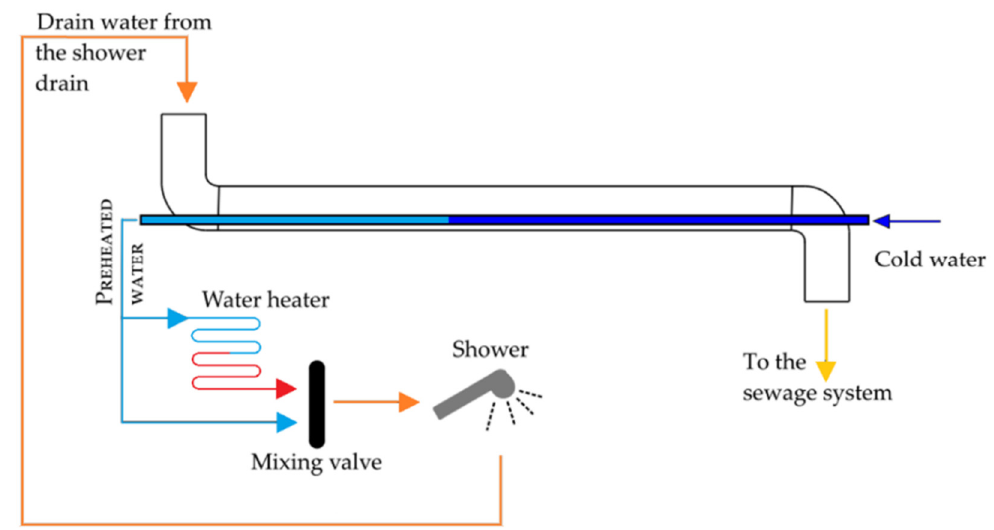
Figure 2. The connection diagram for the heat exchanger with the shower installation.